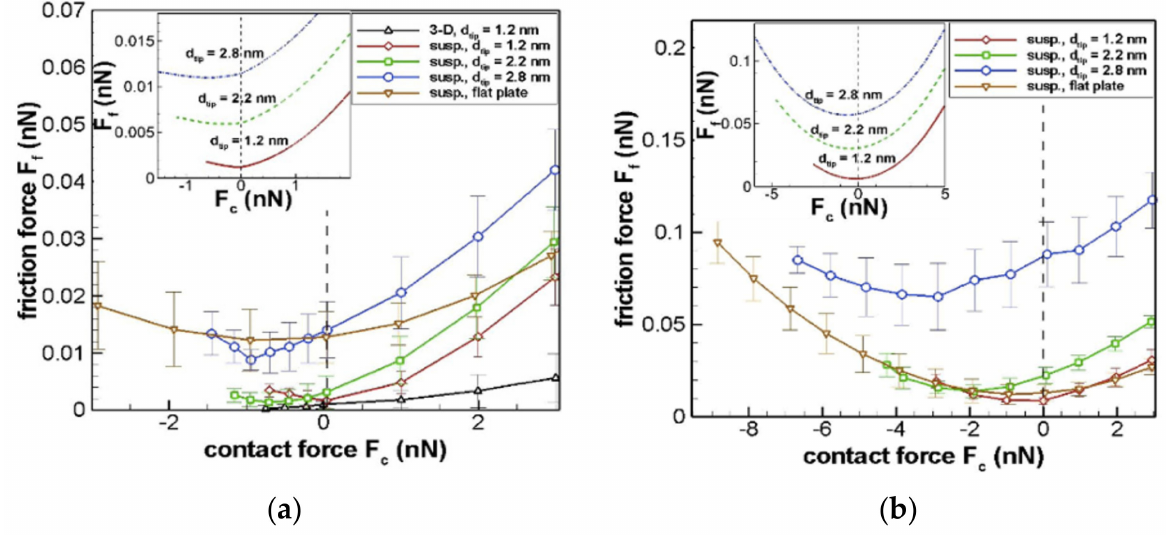
Figure 5. Atomistic simulation result of frictional force( F f ) versus contact force (F c ) for suspended graphene interlayer adhesion: ( a ) tip sample empirical interlayer adhesion, and ( b ) when tip sample interaction Vander Waal’s force increased by 4 times that of ( a ). Inserts show analytical estimates of F f verses F c different spherical tip diameters. (Here, susp indicates suspended graphene whereas 3-D indicates isotropic graphite